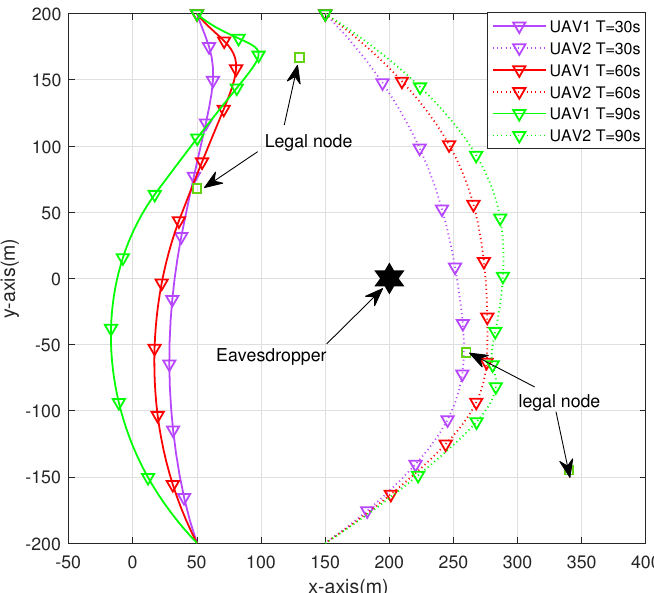
Figure 2. UAV trajectories at different cycle times.